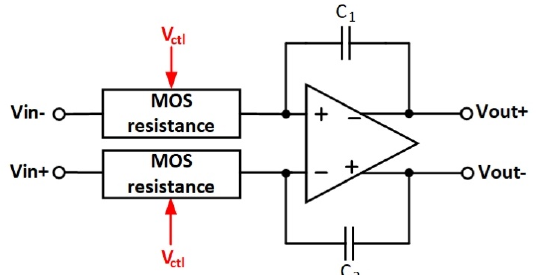
Figure 8. System-level of the low-pass metal-oxide-semiconductor filed-effect transistor-capacitor (MOSFET-C) filter.